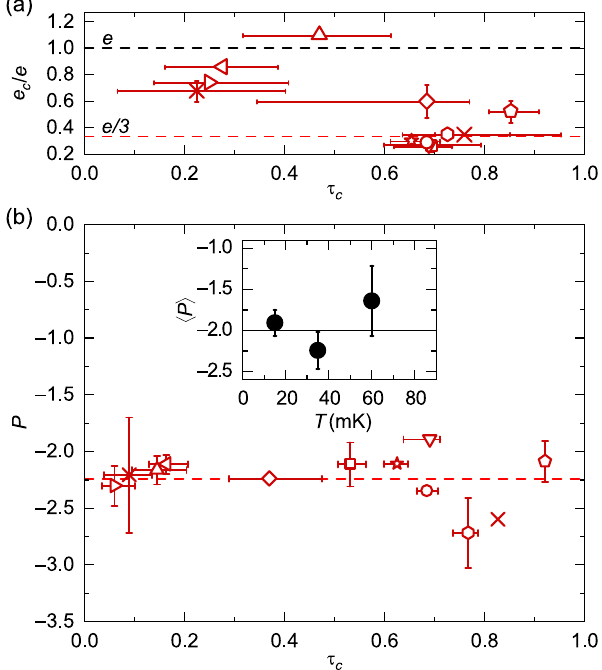
FIG. 3. P ð I − ≈ 0 Þ versus analyzer tuning at ν ¼ 1 = 3 . Identical symbols represent measurements for the same device tuning [ τ c differs in (a) and (b) because of the different biasing]. Error bars are shown if larger than symbols. The horizontal error bars encompass the variation of τ in the range of biases where e c c (a) or P (b) are extracted. The vertical error bars encompass the difference between measurements at negative and positive volt- ≈ e= 3 to e . (b) Indiscernible ages. (a) Analyzer crossover from e c crossover in P ð I − ≈ 0 ; τ . The horizontal dashed line displays c Þ the mean value h P i ≃ − 2 . 2 . Inset: mean value h P i versus temper- ature. The vertical error bars show the standard deviation between values of P for individual analyzer